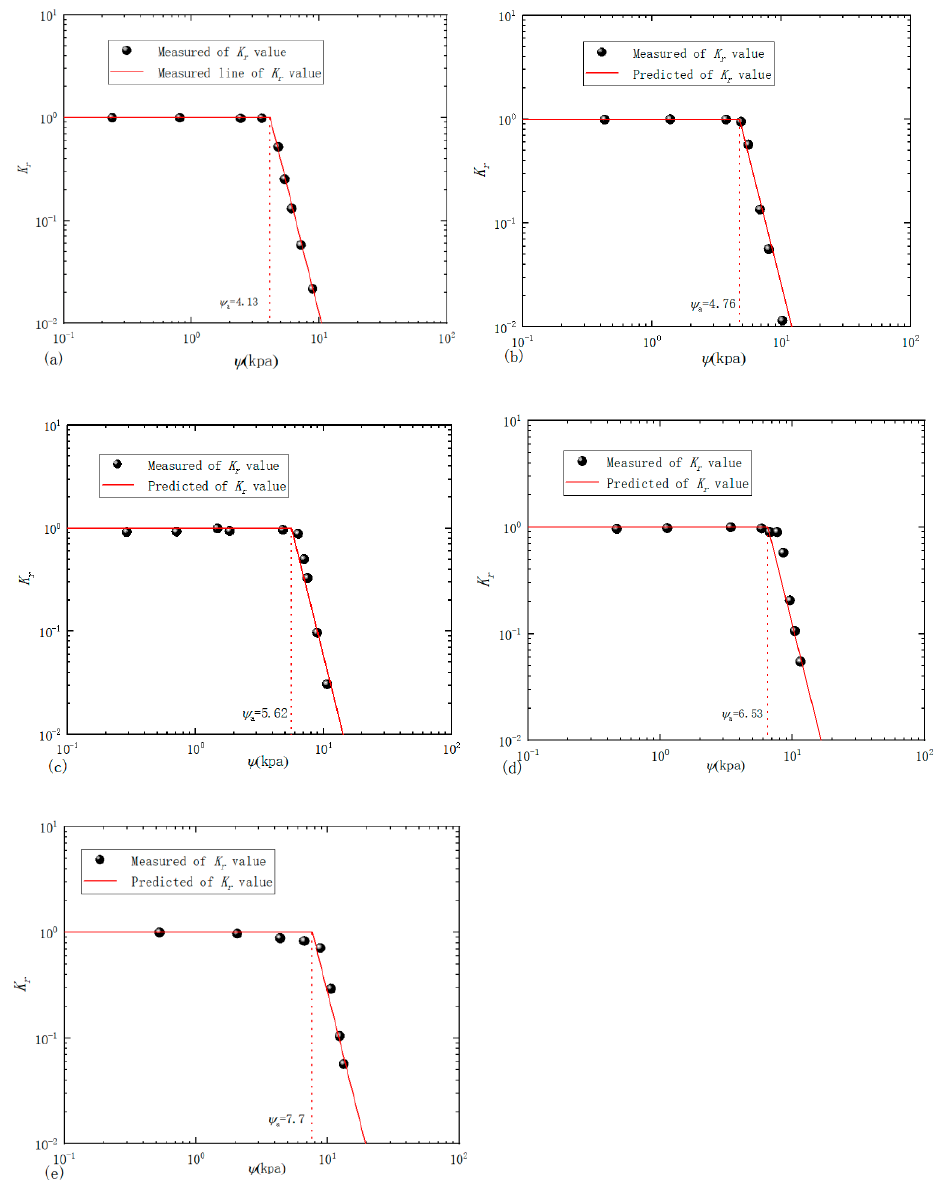
Figure 4. Touchet silt loam’s different porosity ratio unsaturated relative permeability coefficient prediction results: ( a ) e = 1.012; ( b ) e = 0.916; ( c ) e = 0.815; ( d ) e = 0.733; ( e ) e = 0.653.